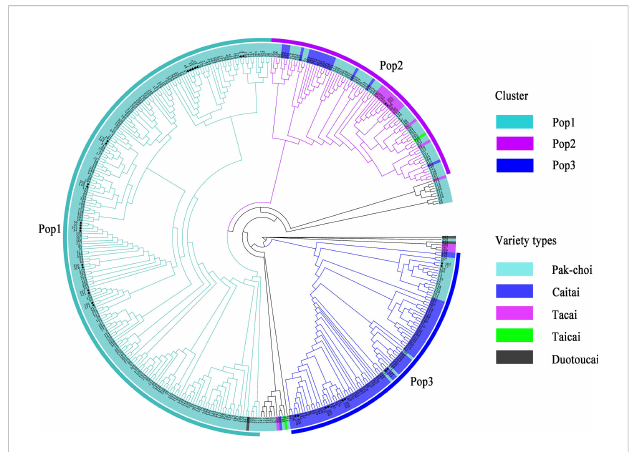
FIGURE 3 Cluster of 423 non-heading Chinese cabbage varieties based on Nei ’ s distance of 23 simple sequence repeat (SSR) markers. ▲ represents two varieties with zero difference in the number of alleles; ★ represents two varieties with one difference in the number of alleles.